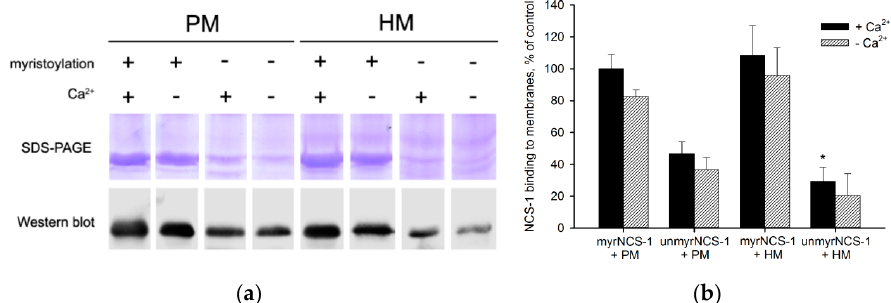
Figure 1. Binding of myristoylated and unmyristoylated neuronal calcium sensor-1 (NCS-1) to urea-washed photoreceptor membranes (PM) and hippocampal membranes (HM) in the presence of 2 mM CaCl 2 (“+Ca 2+ ”) or 2 mM EGTA (“ − Ca 2+ ”). ( a ) Representative results of SDS-PAGE and Western blotting of membrane-bound NCS-1. ( b ) Relative efficiency of membrane binding. The fraction of myristoylated NCS-1 bound to PM in the presence of Ca 2+ was taken as 100%. * p < 0.05 as compared to binding of unmyristoylated NCS-1 to PM in the presence of Ca 2+ .